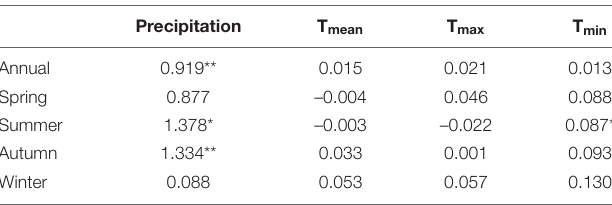
TABLE 2 | Temporal trends of precipitation (mm/a), T mean ( ◦ C/a), T max ( ◦ C/a), and T min ( ◦ C/a) on the western Songnen Plain marshes from 2000 to 2020.